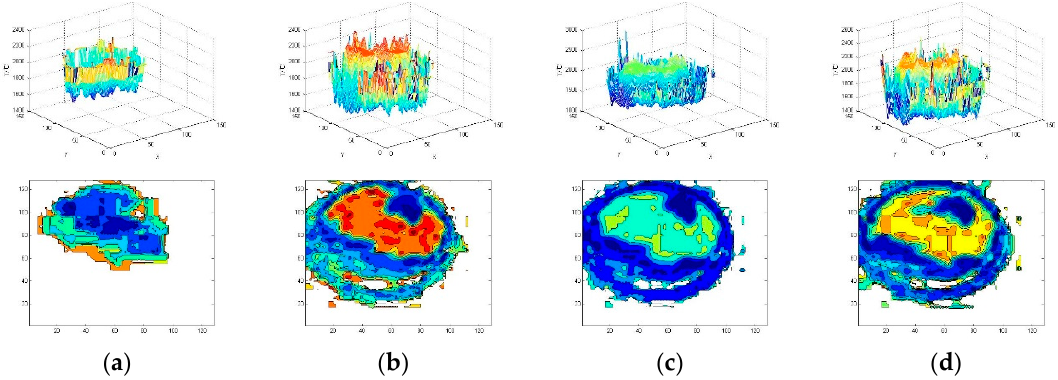
Figure 5. Calculated temperature field image of series 2 with MATLAB. ( a ) Ignition moment; ( b ) maximum pressure rise rate; ( c ) maximum heat release; ( d ) the highest pressure. Figures 6 and 7 processed with the CMS software as competition.